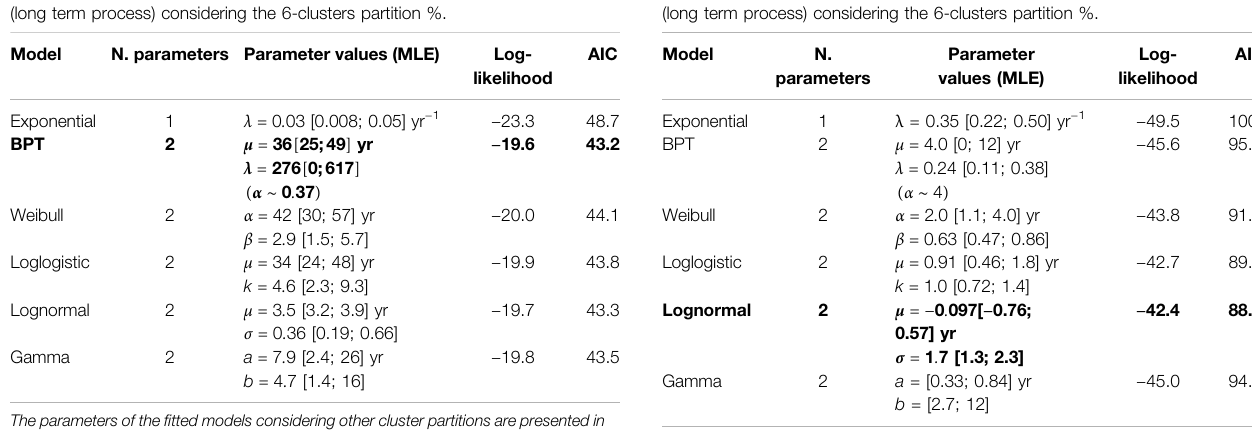
The parameters of the fi tted models consideringother cluster partitionsare presented in the Supplementary Material . In bold we highlight the model with lower AIC (and therefore, the preferred model). In square brackets we provide the 95% con fi dence intervals.